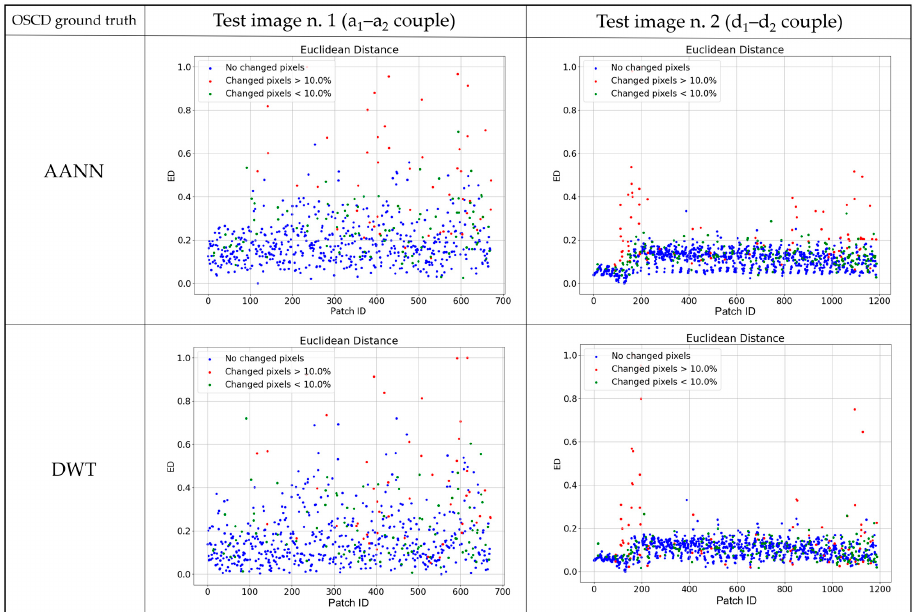
Figure 12. ED value ( y -axis) related to each patch ( x -axis) for the test images 1 in Figure 11a 1 ,a 2 ( left ) and the test images 2 in Figure 11d 1 ,d 2 ( right ). Each marker is colored according to the change condition in the OSCD ground truth patch.